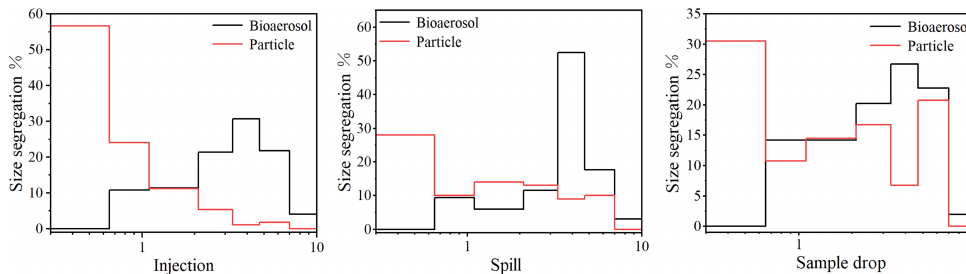
Figure 6. Mass concentration